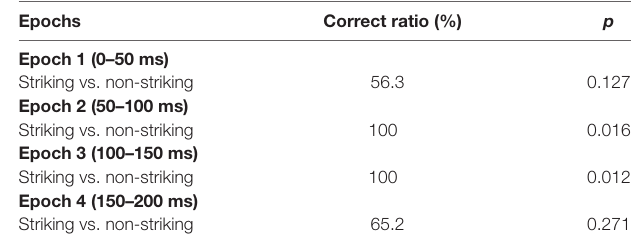
TABLE 1 | Discriminant analyses of the multidimensional scaling (MDS) results in the medial prefrontal cortex